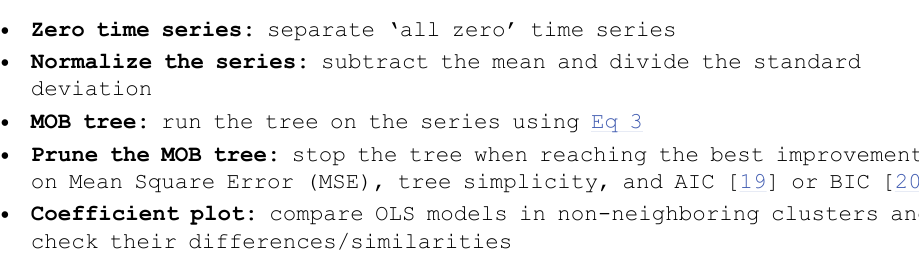
Algorithm 1: MOB time series clustering